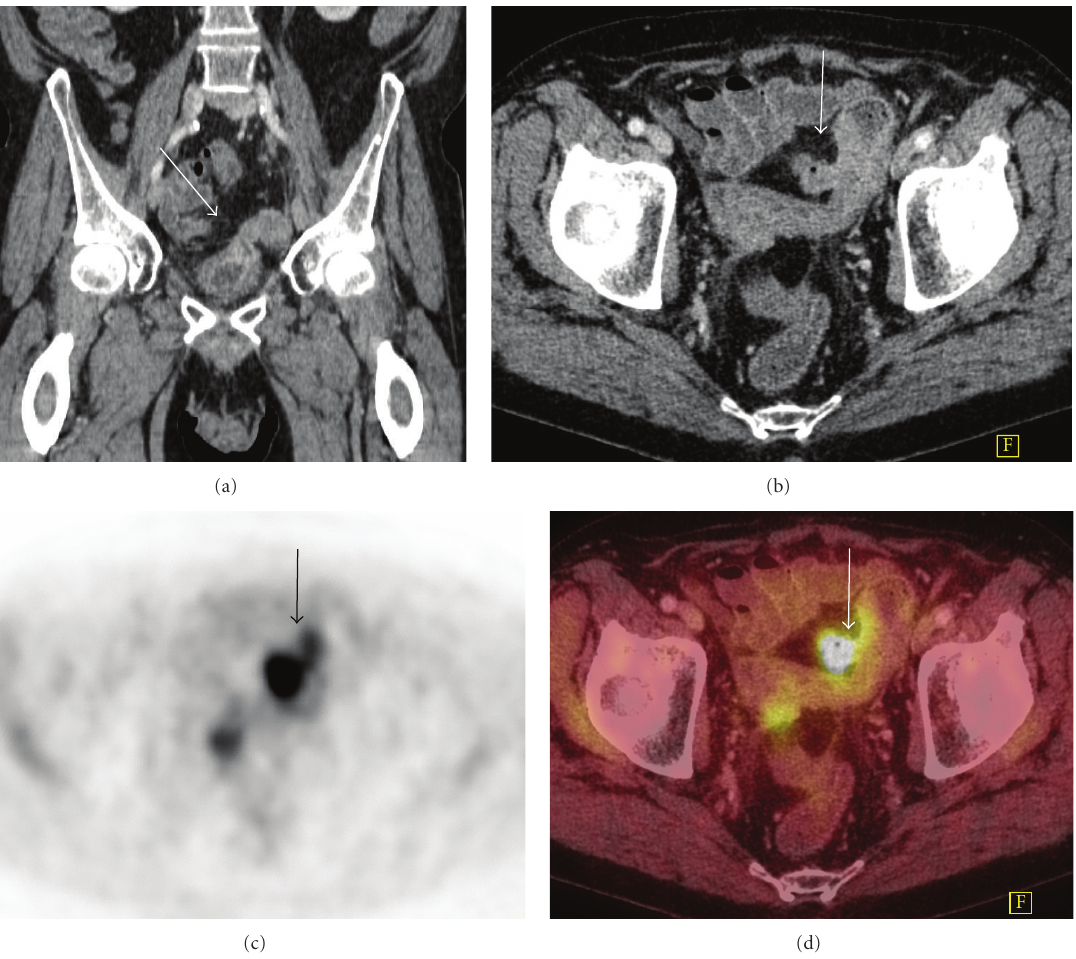
Figure 2: Colovesical fistula in a patient with a prior history of anterior resection for rectal carcinoma. (a) There is a connection (arrow) between the colon and bladder on coronal CT. (b) The colonic end of the fistulous tract (arrow) is seen on axial CT. (c) There is a focus of avid FDG-PET uptake (arrow) present. (d) Fused images confirm that the uptake is within the fistula (arrow) and probably represents urine containing FDG within the fistulous tract. The presence of the fistula and the absence of tumor were confirmed at